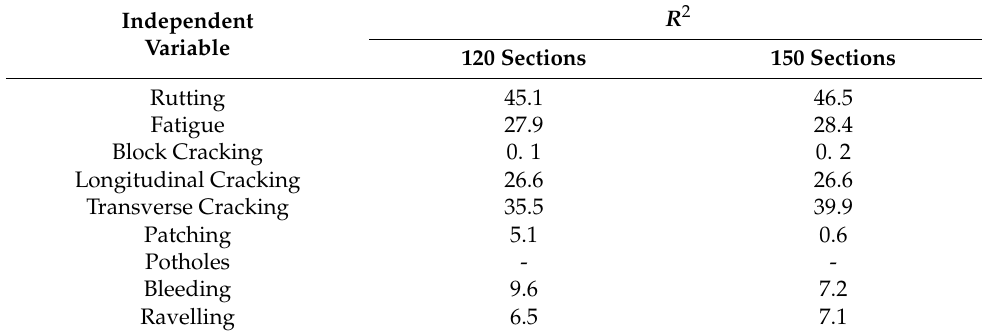
Table 6. Sensitivity analysis of input variables on prediction for